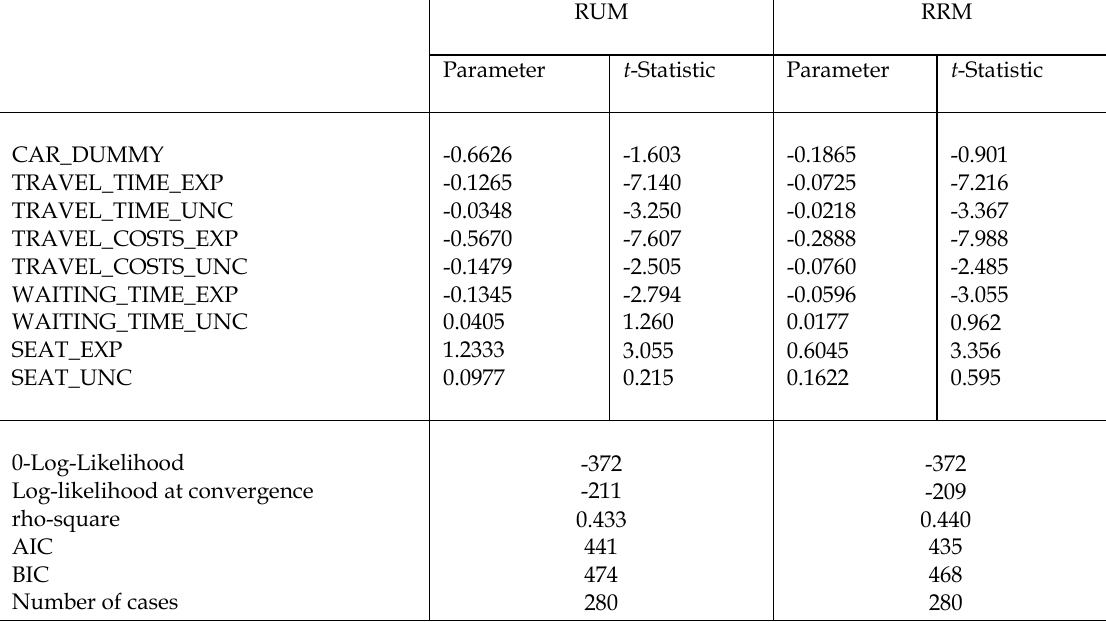
Table 1. Travel mode-/route-choices (estimation results) RUM RRM Parameter t -Statistic Parameter t